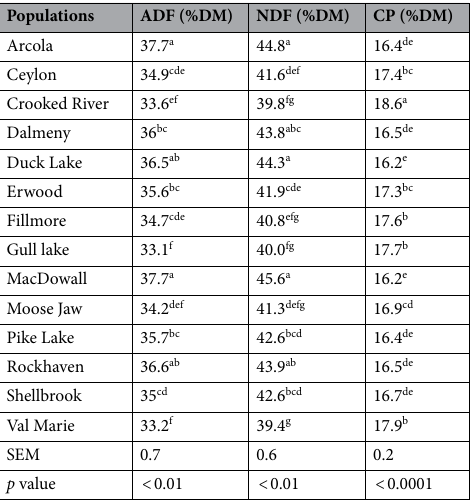
Fig. 1C). Of the 14 populations, five of them (MacDowall, Dalmeny, Fillmore, Arcola and Rockhaven) were the top yielding populations (Table 1), while the top five rapid regrowing populations included Erwood, and Gull Lake in addition to the highest yielding populations (Table 1). The five early fall dormant populations based on fall plant height were Ceylon, Val Marie, Pike Lake, Rockhaven and Arcola, with falcata parentages of 29%, 34%, 21%, 30%, and 24%, respectively (Table 1 and Fig. 1C). The later dormant populations were MacDowall, Dal- meny, Duck Lake, Moose Jaw and Gull Lake, with sativa percentages of 84%, 80%, 85%, 82% and 90% (Table 1 and Fig. 1C). Among the four soil zones, the populations from the Black soil zone, the moistest region, had the highest forage yield, spring vigor, plant height, regrowth and fall plant height compared to the other three soil zones (Table 2). The populations from the Brown soil zone, the driest among four, had the lowest forage, spring vigor, plant height and regrowth (Table 2). The GDDs for days to flower was higher for the populations from two southern soil zones (Brown and Dark Brown soil zones) than the two northern zones (Black and Grey Wooded soil zones) (Table 2). Forage dry matter yield and regrowth were similar between populations from the Dark Brown and Grey Wooded soil zones (Table 2). The fall plant height was taller for the populations from the Black and Dark Brown soil zones than from the Brown and Grey Wooded soil zones (Table 2). Significant variation existed among the 14 alfalfa populations from long-term grazing sites in each of the three nutritive value measurements ( p < 0.01) and among the four soil zones ( p < 0.001) (Tables 3 and 4). The concen- trations of ADF ranged from 33.1 to 37.7%, and NDF ranged from 39.4 to 45.6%. The populations from Arcola and MacDowall had the highest concentrations of ADF and NDF, while populations from Crooked River had the lowest ADF and NDF concentrations (Table 3). The concentration of CP ranged from 16.2 to 18.6% among the 14 alfalfa populations from long-term grazing sites. The Crooked River population produced the highest CP concentration, followed by the Val Marie and Gull Lake populations (Table 3). Populations from the Black soil